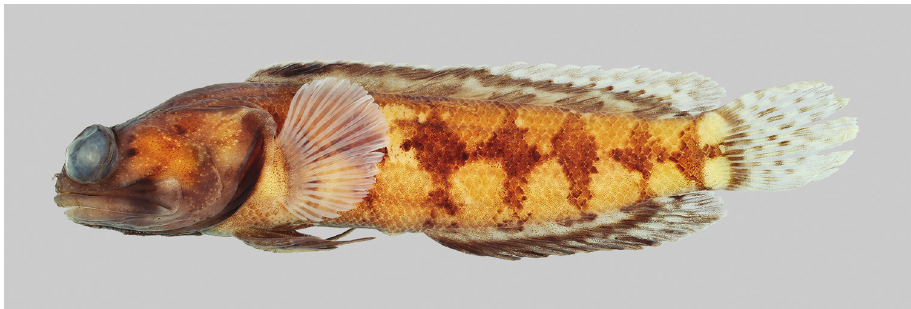
Figure 9. Opistognathus vicinus , NPM 5030, preserved paratype, 47.4 mm SL, Ilha Rasa, Guarapari, Espírito Santo, Brazil. Photograph by Zackary S. Randall.